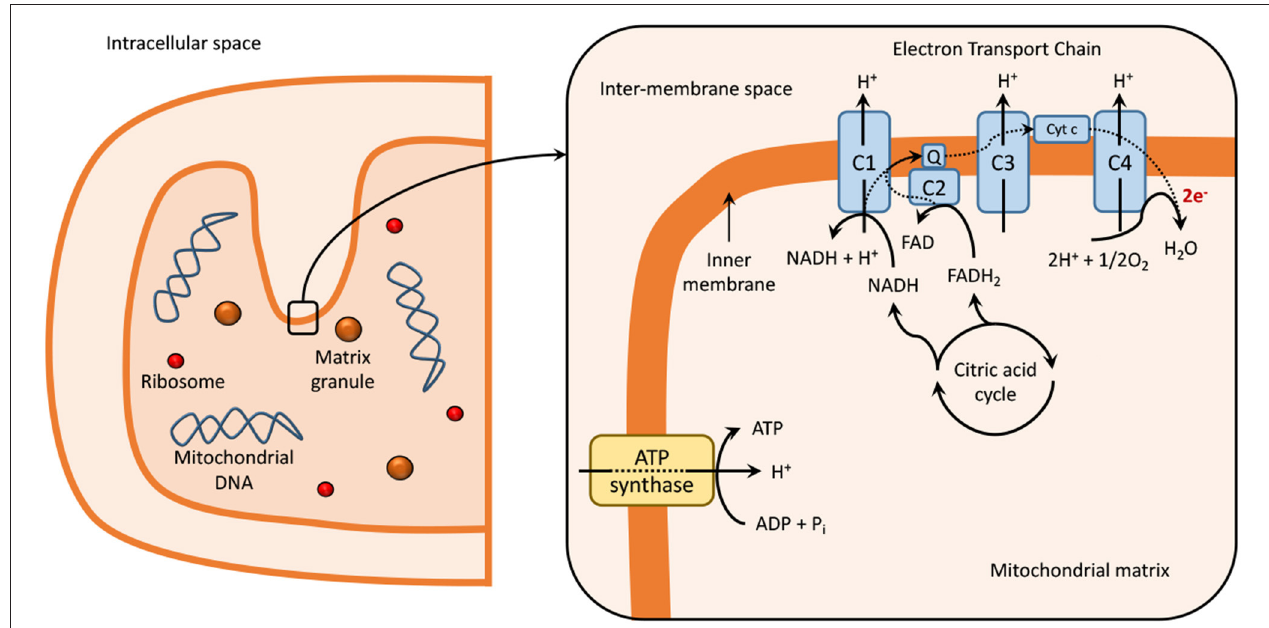
FIGURE 1 | Mitochondria at normal physiological conditions. Dashed lines represent electron transport in the electron transport chain reaction (ETC). The ETC is localized within the inner mitochondrial membrane or cristae of the mitochondria (21–23) and is composed of five multimeric protein complexes (I-IV and ATP-synthase or complex V) that are responsible for ATP production by oxidative phosphorylation. Complex I, or nicotinamide adenine dinucleotide (NAD + ), and/or complex II (succinate dehydrogenase), begin the process of oxidative phosphorylation by catalyzing the transfer of electrons from NADH and FADH 2 , respectively, to coenzyme Q (or ubiquinone). The transfer of electrons is serially conducted through complex III (ubiquinol: cytochrome c oxidoreductase), cytochrome c and complex IV (cytochrome c oxidase), to the terminal acceptor, generating an electrochemical proton gradient that enhances ATP production in complex V via oxidative phosphorylation ( 1, 24, 25). During this process, single-electrons can escape and produce a single-electron reduction of O 2 , forming superoxides and other ROS ( 24, 26, 27). Impaired functioning of ETC can result in excessive ROS production, which leads to the damage of DNA, lipids, proteins, and other molecules in a process known as oxidative damage (1, 24, 27). The generation of ROS is also related to signaling physiological processes, such as synaptic plasticity and memory (28). C, complex; Cyt c, cytocrome c; e-, electron; ECT, electron transport chain; FAD, flavin adenine dinucleotide; Q, coenzyme Q; NAD, nicotinamide adenine